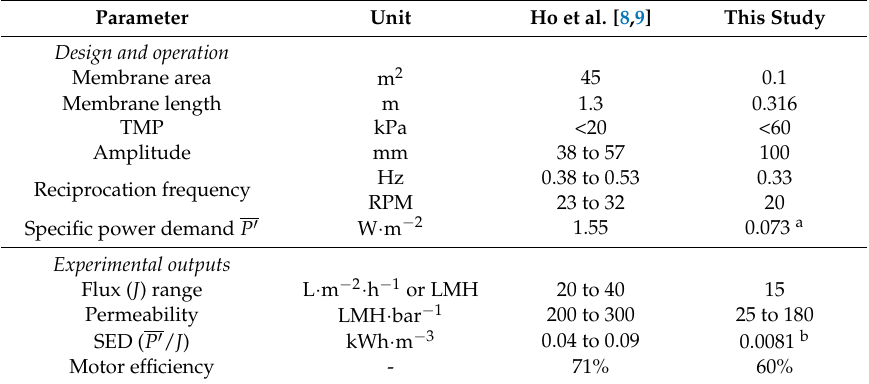
Table 3. Results from current study vs. published pilot-scale mechanical shear, Ho et al. [8,9]. Parameter Unit Ho et al. [8,9] This Study Design and operation Membrane